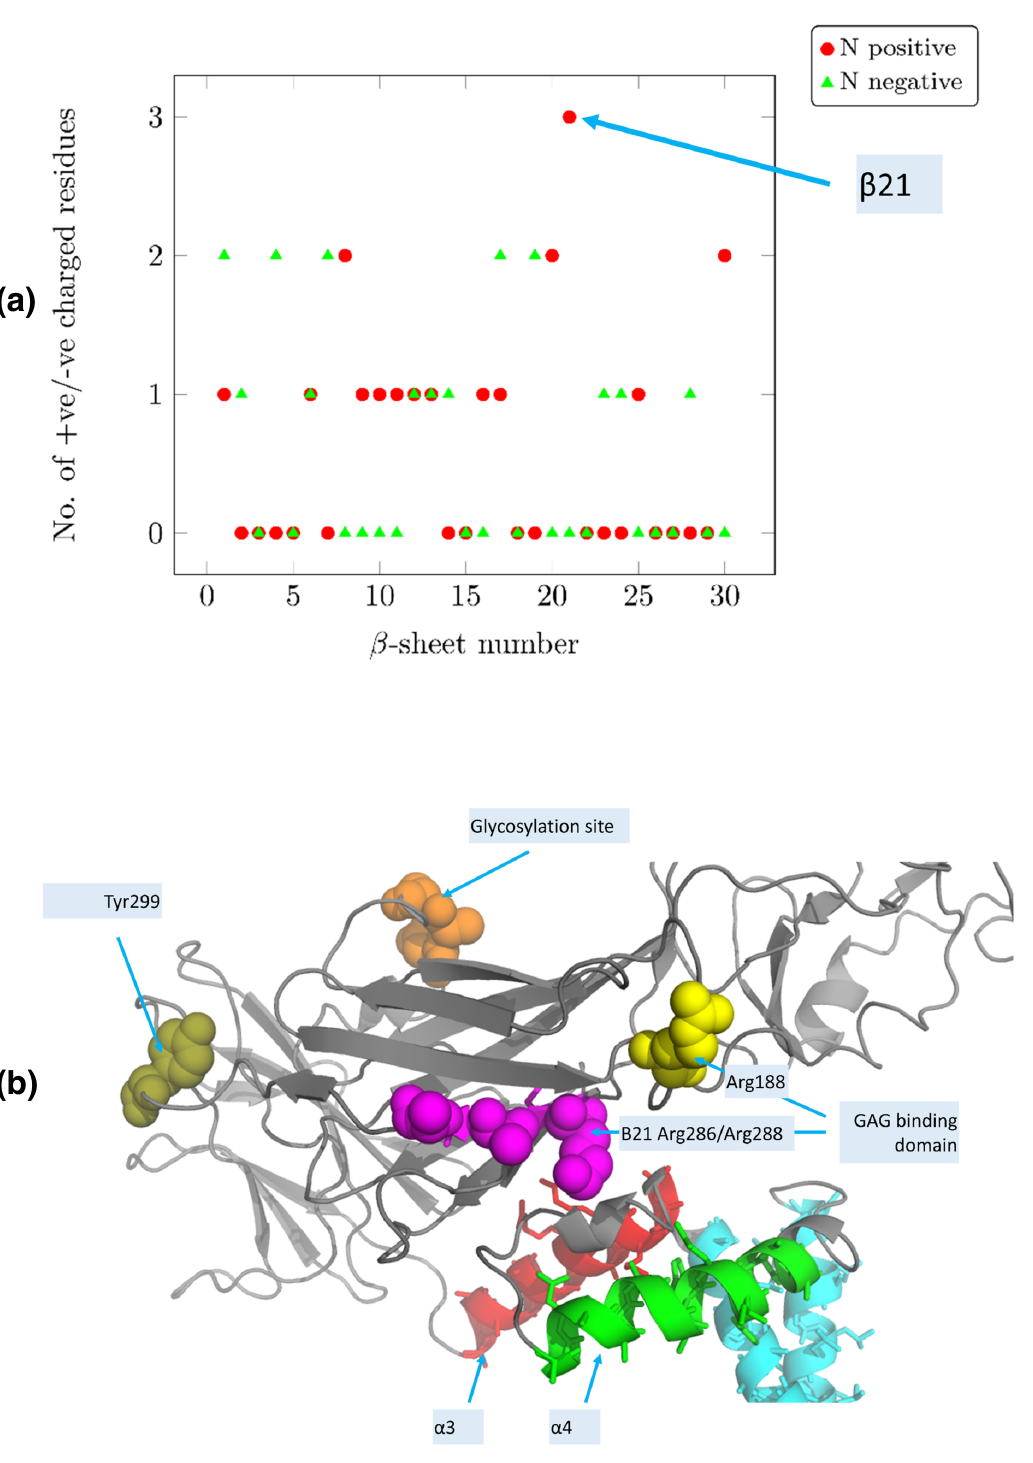
Figure 7. Charged profile of β -sheets in the ZIKV-E protein (PDB ID:5IREA). ( a ) β -21 in ZIKV-E is the most distinctive, and has three positively charged residues (290:KCRLK). The stereochemical nature of these residues are conserved in ZIKV/DENV1-4/JEV/WNV (Figure 3). ( b ) β 21 is part of the GAG-binding domain that precedes the domain I/III linker, and is physically proximal to the cationic α 4. This sheet has a pair (DENV:Arg286-Arg288) with electrostatic polarity reversal post-fusion. A mutation of Tyr299 to Phe299 disrupted virus-like particle assembly, although it was compensated by a mutation in α 3 (DENV-E Q400H), which is distant from